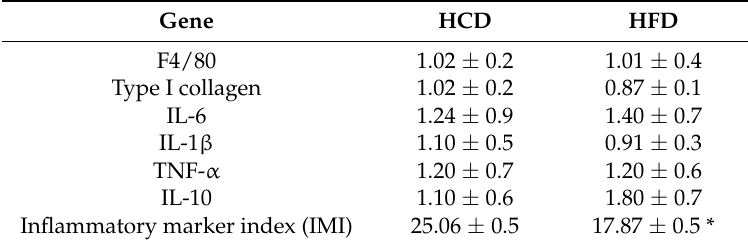
Table 6. Expressions of inflammatory genes (by RT-PCR) in the liver from mice fed with either high fat diet (HFD group) or high carbohydrate diet (HCD group) for 56 days.